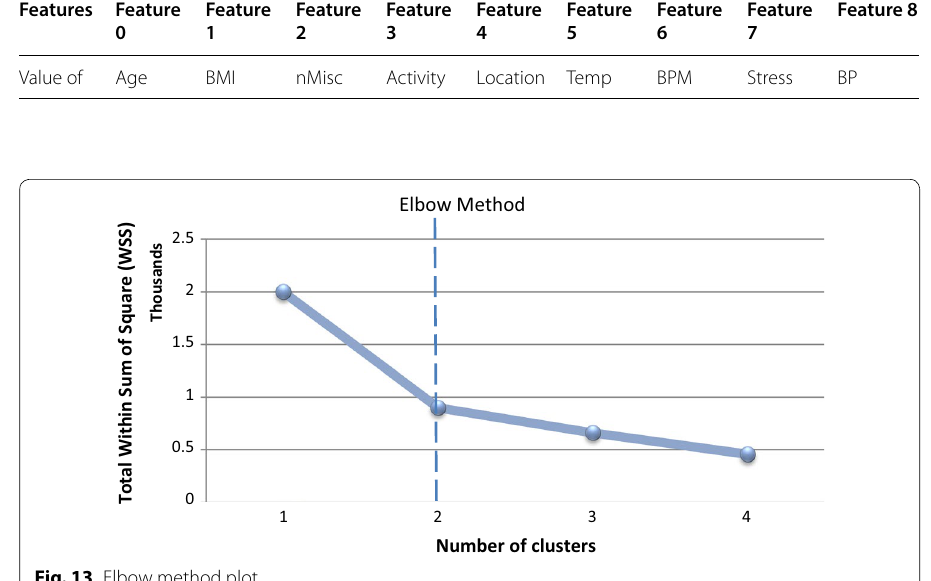
Fig. 13 Elbow method